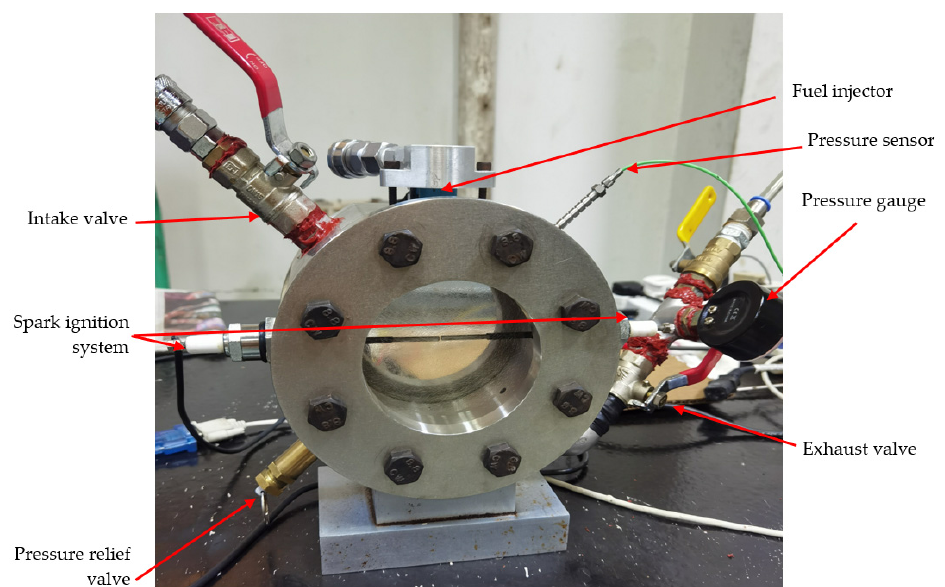
Figure 4. Setup of CVCC system.